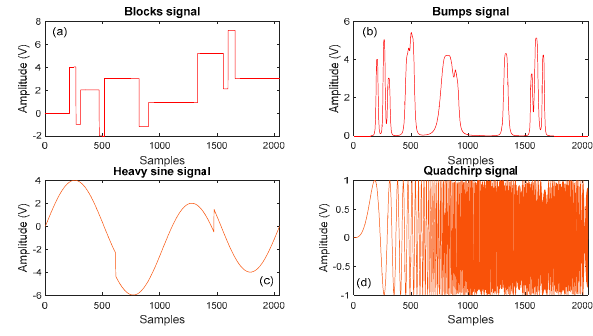
Figure 6. Simulation of the noisy signal.